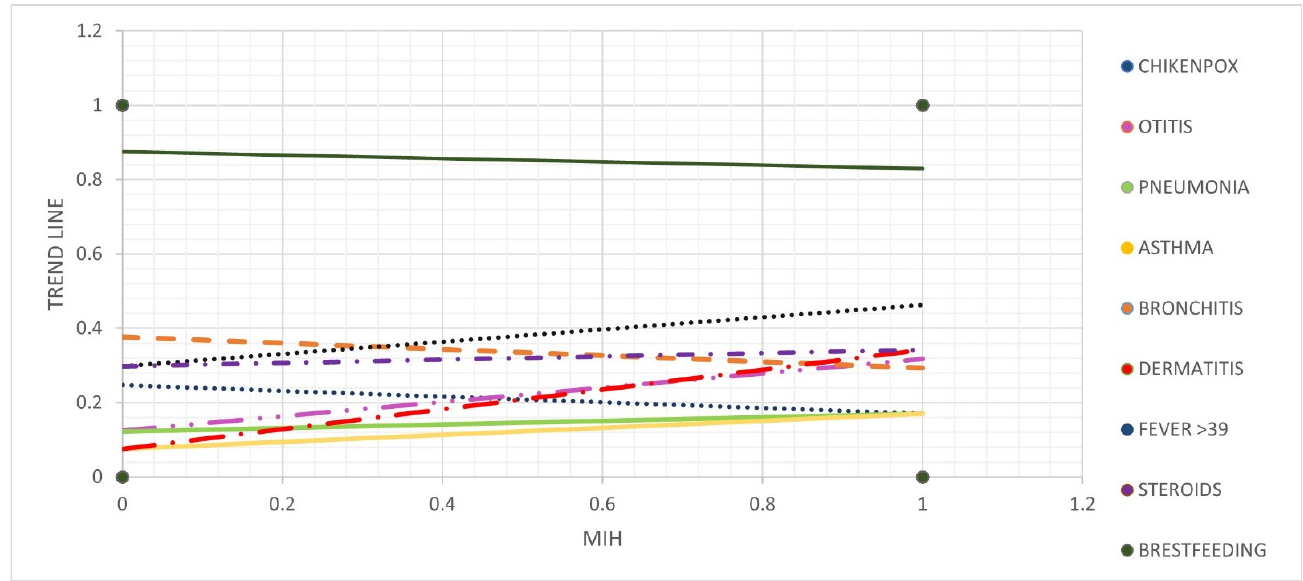
Figure 1. Etiological factors influencing MIH with a trend line. Table 7. The distribution of potential etiological environmental factors in the MIH and non-MIH groups.